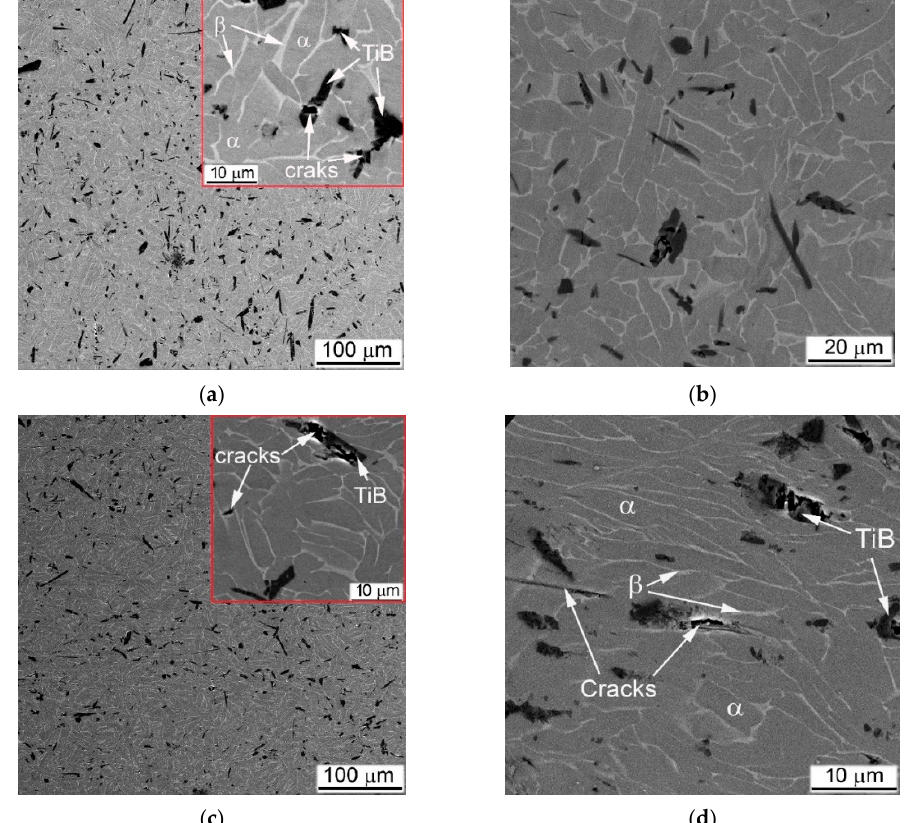
Figure 16. SEM BSE images of Ti64 + 5TiB after the high-strain-rate SHPB test with rates ( a , b )—1430 s − 1 , ( c , d )—2930 s − 1 . ( a , c )—Zone II; ( b , d )—Zone I.